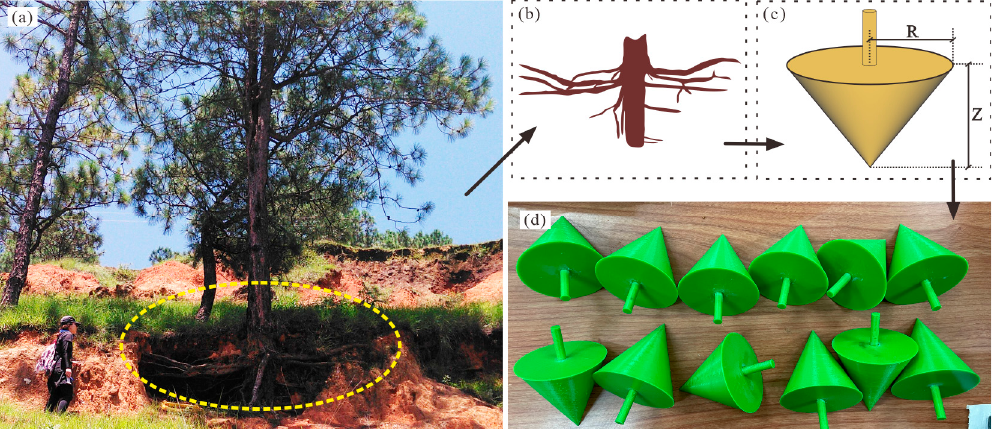
Figure 4. Pine root morphology exposed at the site. ( a ) Real root system; ( b ) Root morphology; ( c ) Root-soil composite of tap-like pine tree; ( d ) 3D printed root-soil composite.